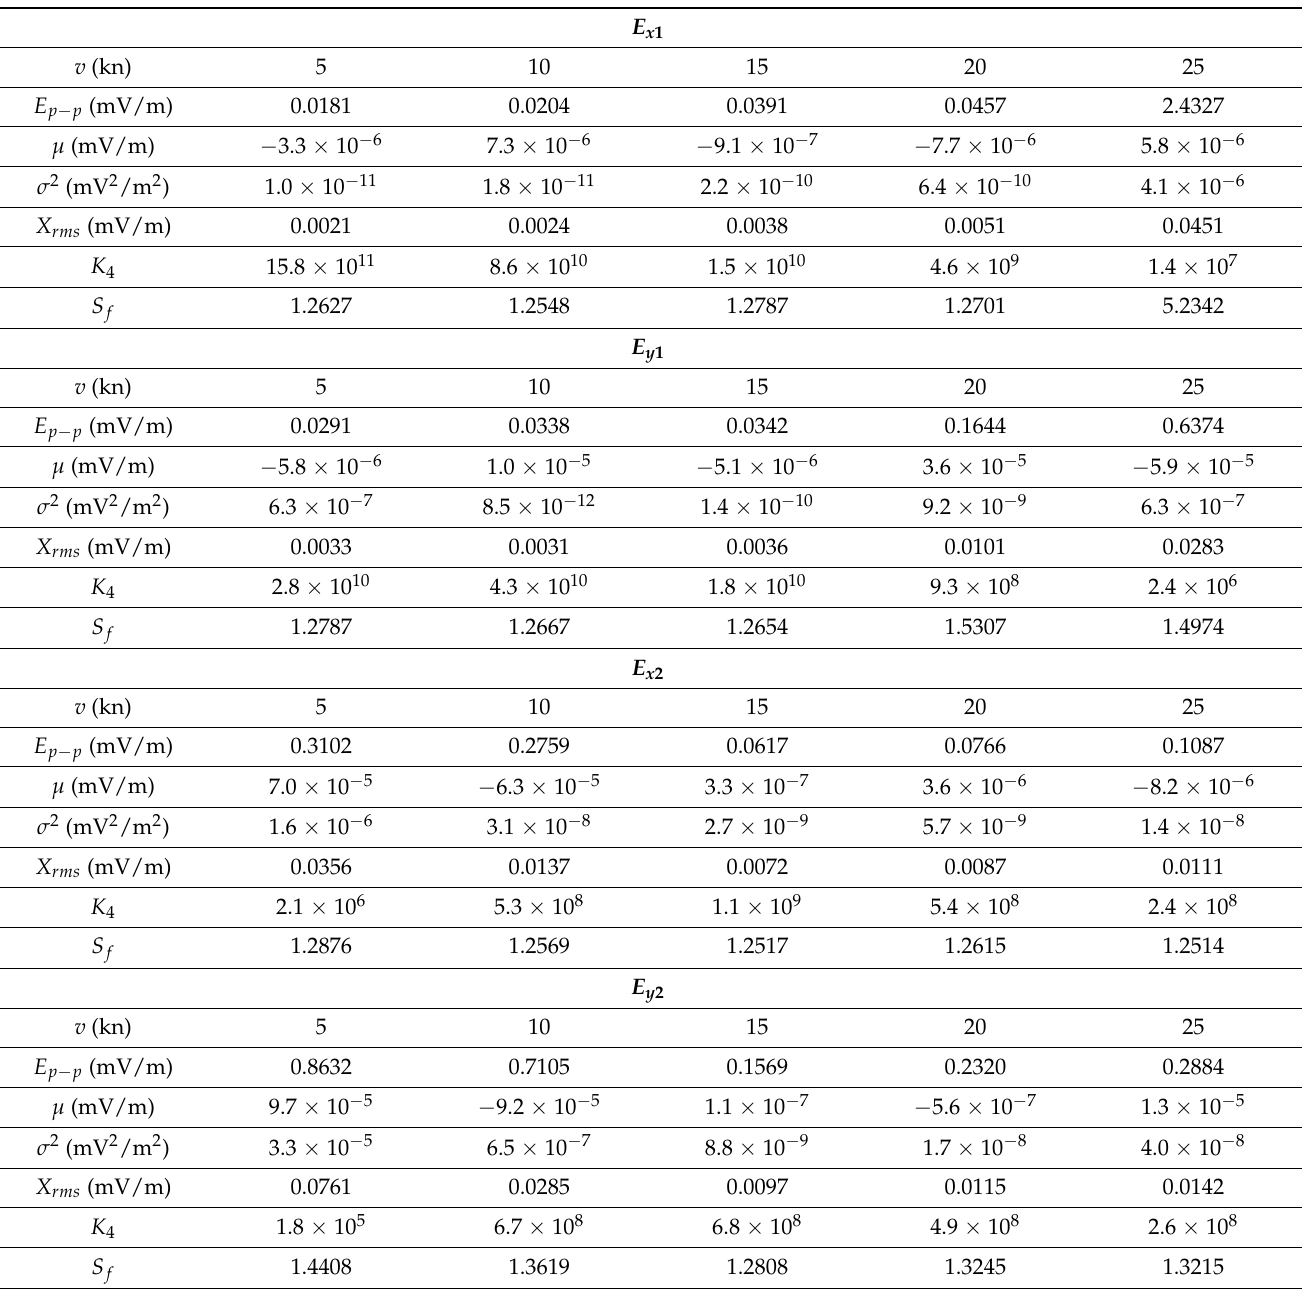
Table 3. Calculation results of characteristic